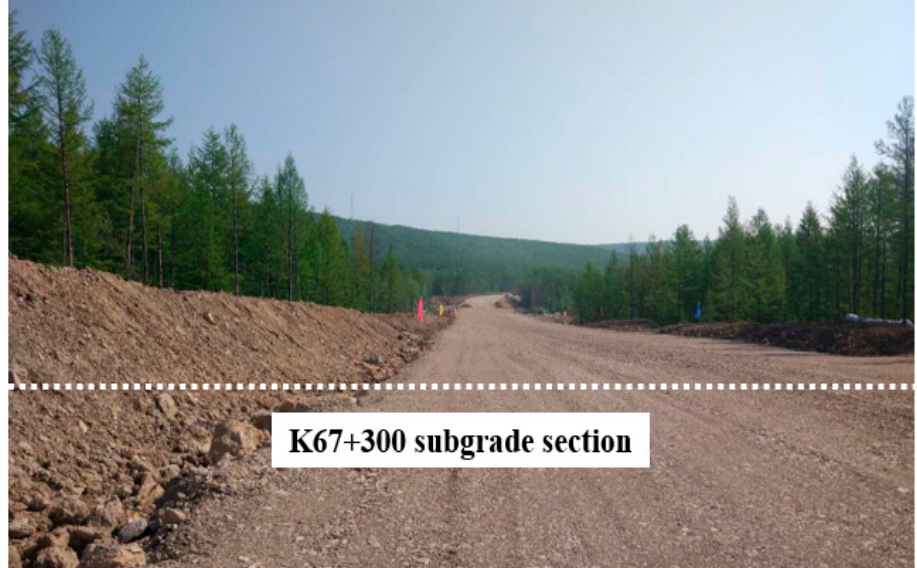
Figure 2. Real view of the K67+300 subgrade section.